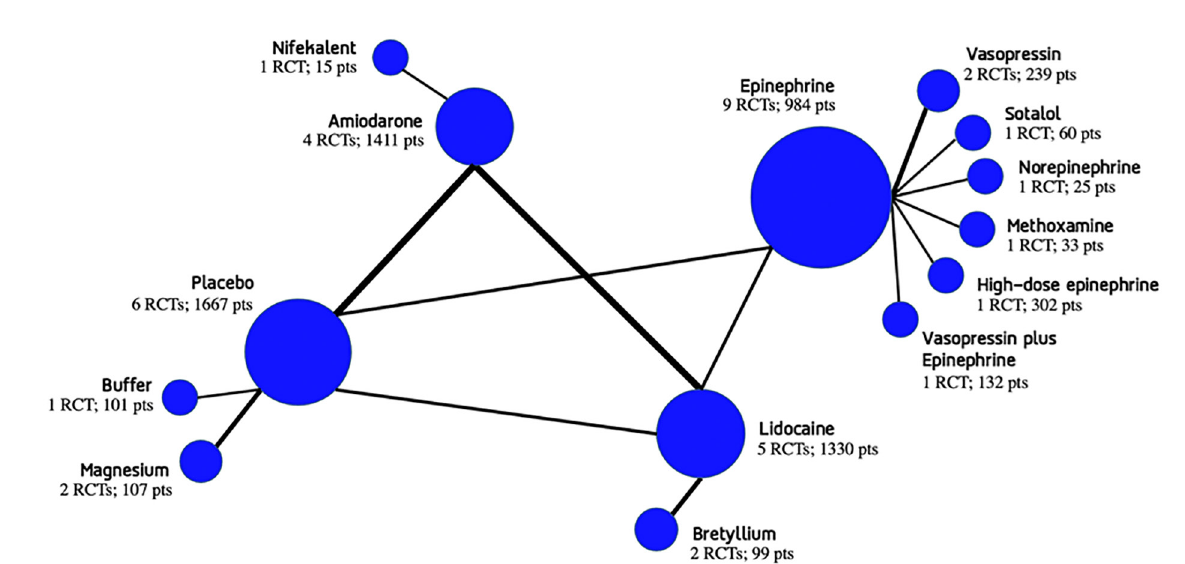
Figure 2. Network graph of 12 medications and placebo. The width of the lines is proportional to the sample